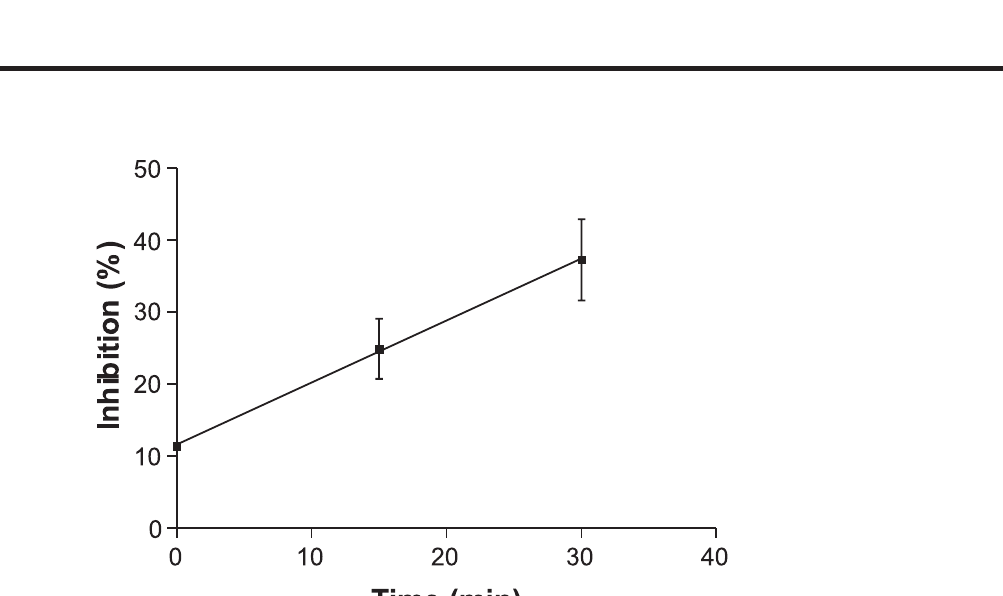
FIGURE 1 – Correlation between the inhibition of liver mitochondrial state 2 FADH liver homogenates in the presence of 1 mM catechol prior to mitochondrial isolation (Pearson’s correlation, 0.96458; P <